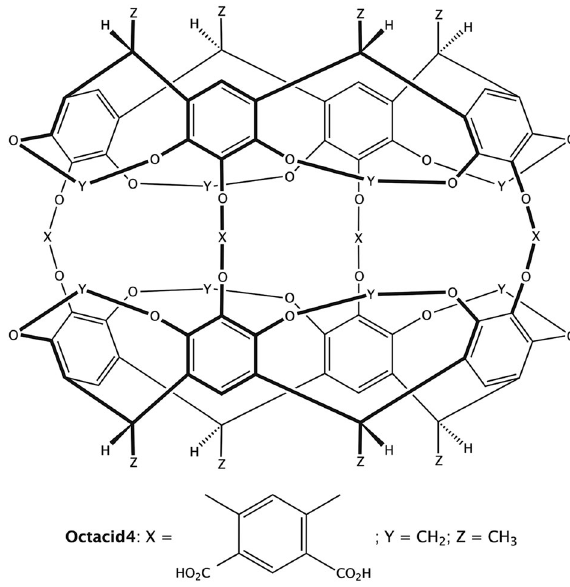
Fig. 1 Chemical structures of hemicarcerands and